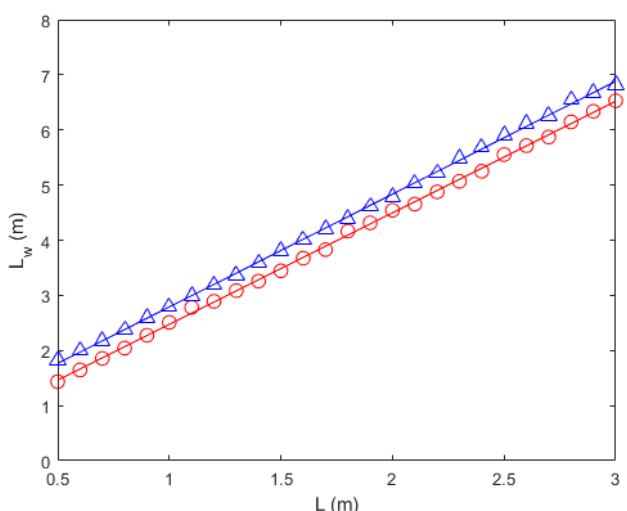
Figure 12. Wavelength L w as functions of moving bottom length L . Circle (Set I): h 0 = 0.03 m, a = 0.02 m, b = 0.5 s. Square (Set II): h 0 = 0.05 m, a = 0.05 m, b = 1 s. Lines show the corresponding linear fitting for 0.5 < L < 3 m. In both case, θ = 0 and the upward bottom motion, (1), is imposed.